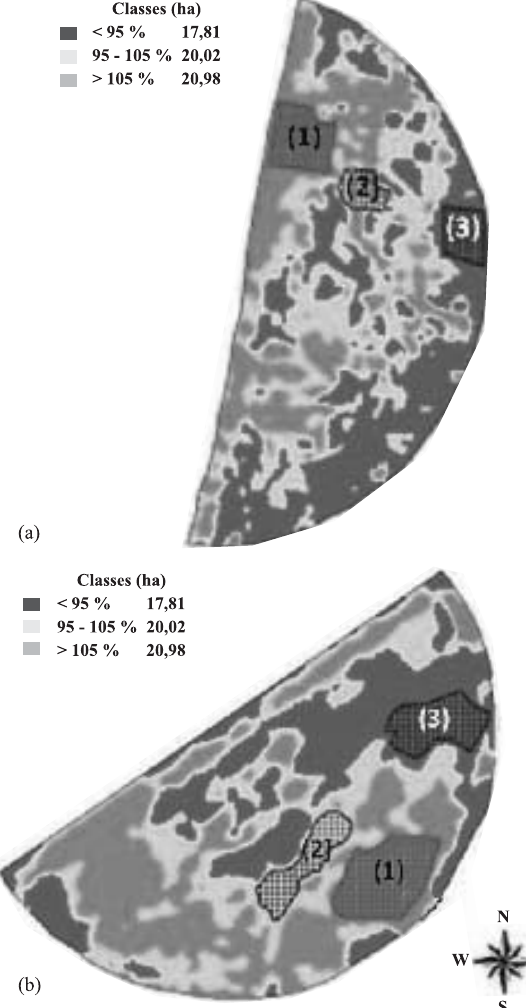
Figura 1. Espacialização das zonas de rendimento (1: zona de alto rendimento; 2: zona de médio rendimento; e 3: zona de baixo rendimento) de feijão-preto nas safras de 2005/2006 e 2006 em Trindade do Sul (a) e de milho nas safras de 2002/ 2003 e 2003/2004 em Palmeira das Missões (b), nas quais foi feita a caracterização de atributos do